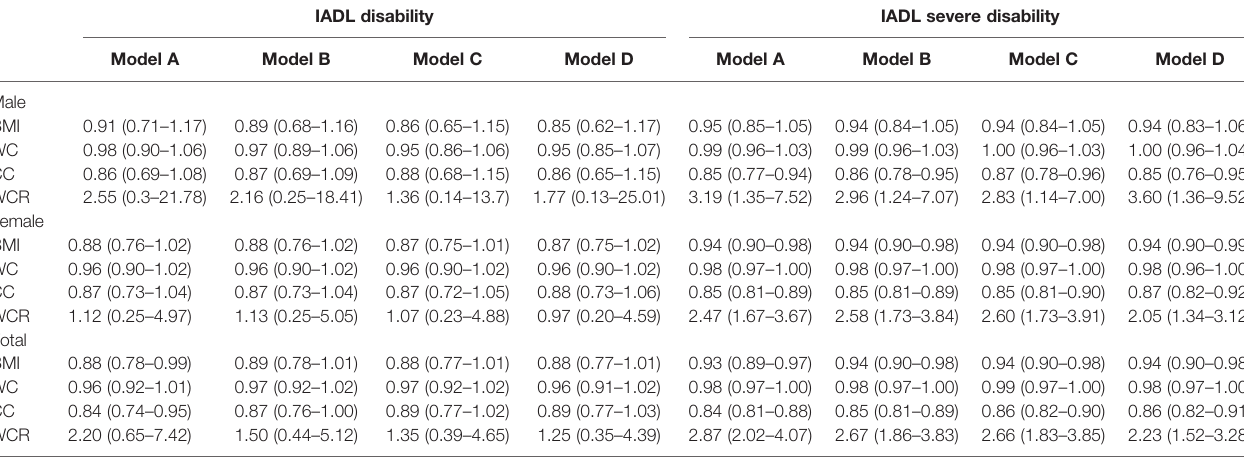
BMI, body mass index; WC, waist circumference; CC, calf circumference; WCR, waist-calf circumference ratio. Model A: crude model; Model B: Adjusted for gender, age; Model C: Adjusted for gender, age, ethnic, education level, residential type; Model D: Adjusted for gender, age, ethnic, education level, residential type, smoking, drinking, physical activity.